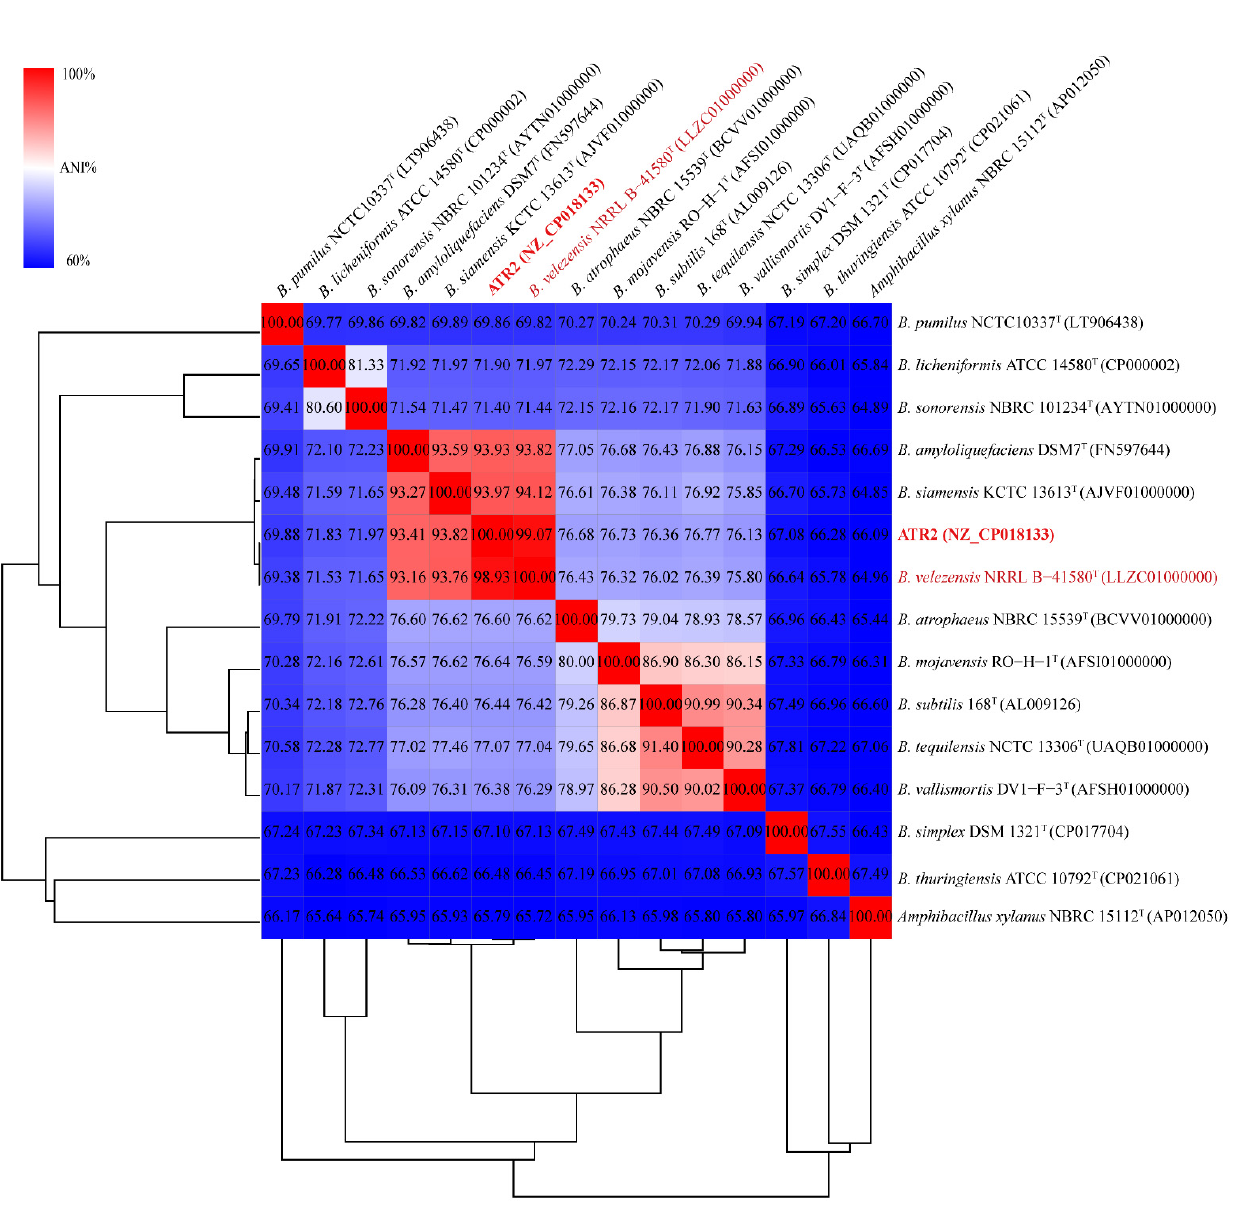
Figure 1. Heat-map analysis based on the ANI values of strain ATR2 and related strains. Strain ATR2 was highlighted in bold with red letters. B. velezensis NRRL B-41580 T was highlighted with red letters. Numbers in parentheses represented the GenBank accession numbers.